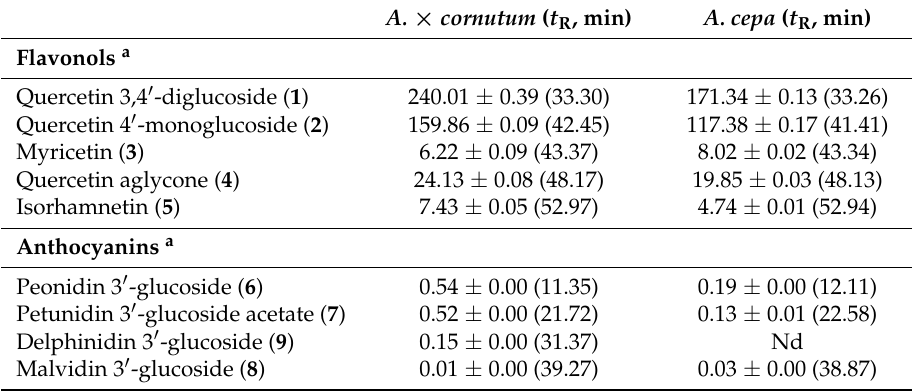
Table 1. HPLC quantification of flavonols and anthocyanins in A. cepa and A. × cornutum extracts.